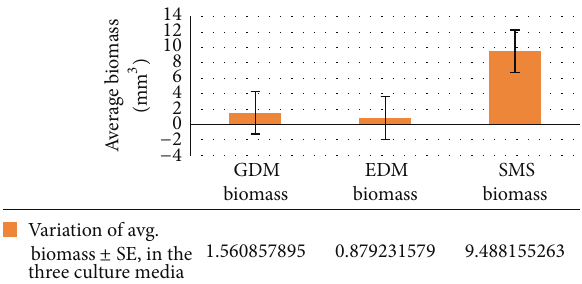
Figure 3: Variation of avg. biomass ± SE, in the three culture